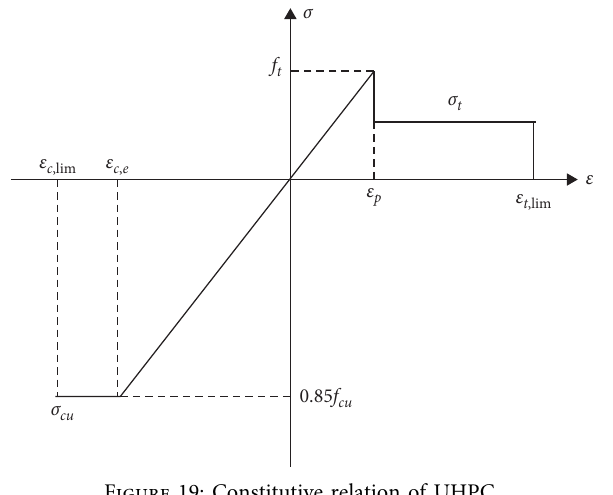
Figure 19: Constitutive relation of UHPC.